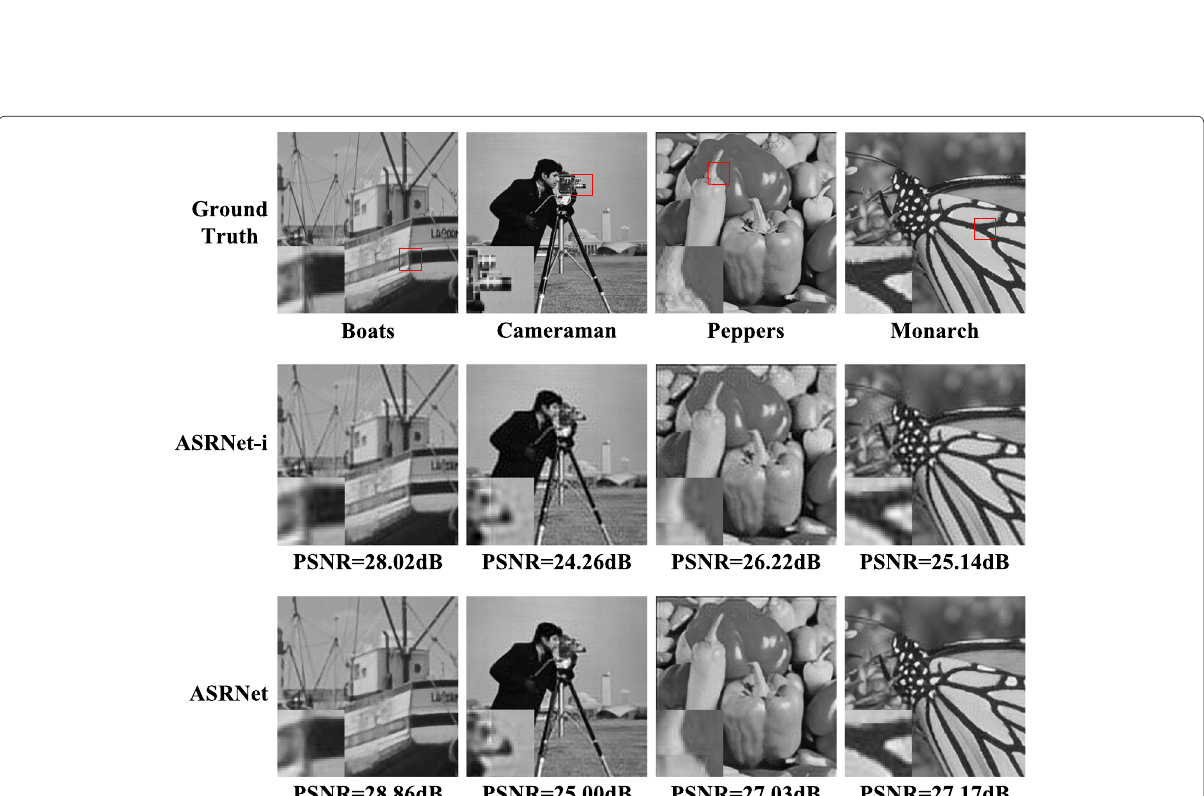
Fig. 20 The intermediate and final reconstruction results of ASRNet at the measurement rate